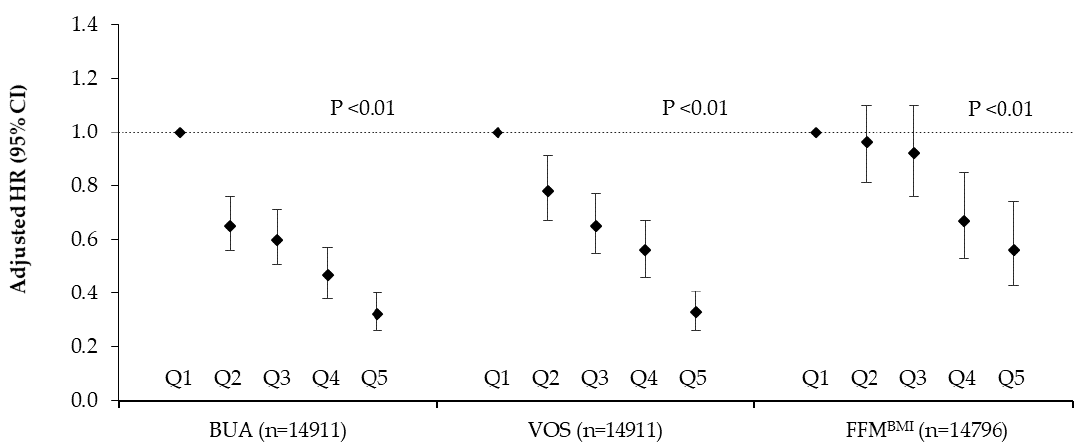
Figure 2. Total fracture risk after a mean follow up of 17.6 years by quintile of broadband ultrasound attenuation, velocity of sound and fat free mass in 14,911 men and women aged 39–79 years. Values are adjusted hazard ratios (95% CI), n = 14,911. Ratios were adjusted for sex, age, BMI, smoking, physical activity, family history of osteoporosis, medication use (corticosteroids, aspirin or hormone replacement therapy) and menopausal status. BMI was not included in the FFM BMI model. p values are for trends calculated using the Cox proportional hazards model. Participant numbers (cases) per quintile were as follows; BUA: Q1 = 2985 (505), Q2 = 2981 (266), Q3 = 2981 (213), Q4 = 2982 (157), Q5 = 2982 (105). VOS: Q1 = 2994 (464), Q2 = 2989 (292), Q3 = 2991 (224), Q4 = 2972 (172), Q5 = 2965 (94). FFM BMI : Q1 = 2960 (308), Q2 = 2959 (325), Q3 = 2959 (270), Q4 = 2959 (182), Q5 = 2959 (145). BUA =